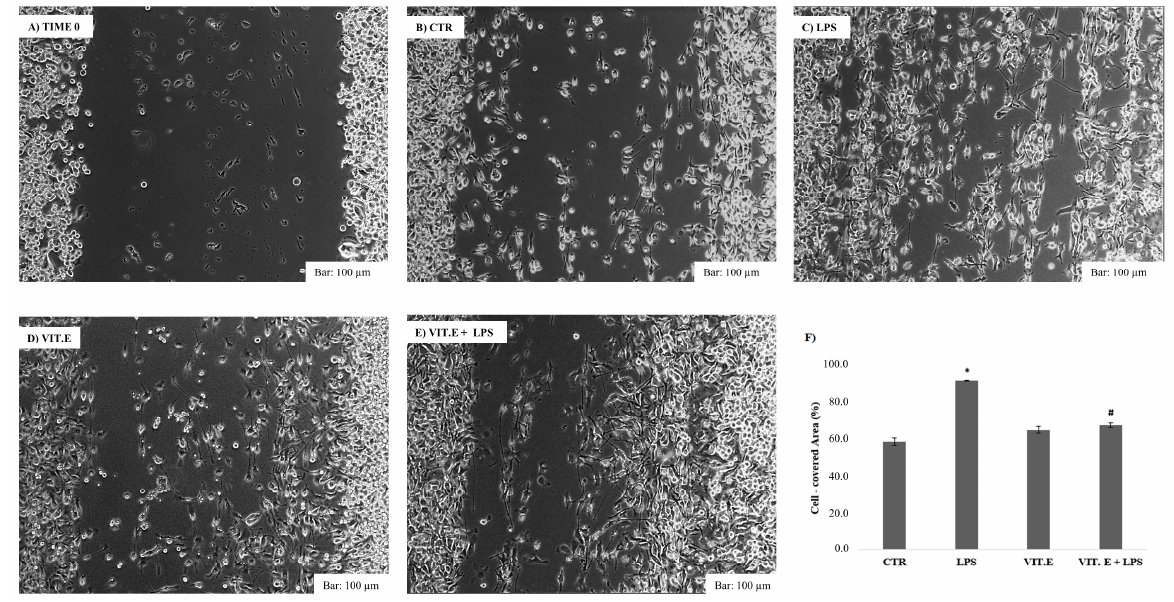
Figure 3. Analysis of the migratory capacity of microglia following the administration of vitamin E with or without LPS. A wound was procured from a sub-confluent layer of BV2 cells, and the resulting space was imaged at the time of the wound and 24 h after the treatment: BV2 cells at time 0 ( A ), 24 h after the cut in the control condition ( B ), with 1 µ g/mL LPS ( C ), with 100 µ M vitamin E ( D ), and with 100 µ M vitamin E in the presence of 1 µ g/mL LPS ( E ). The images are representative of an experiment with three independent replicates. The percentage of the wound gap was analyzed using ImageJ software and subsequently plotted and statistically analyzed as the percentage of wound closure compared to the 0 time condition ( F ). Values are presented as means ± SDs. Bar: 100 µ m (10 × objective). * p < 0.05 compared to control. # p < 0.05 compared to LPS condition.